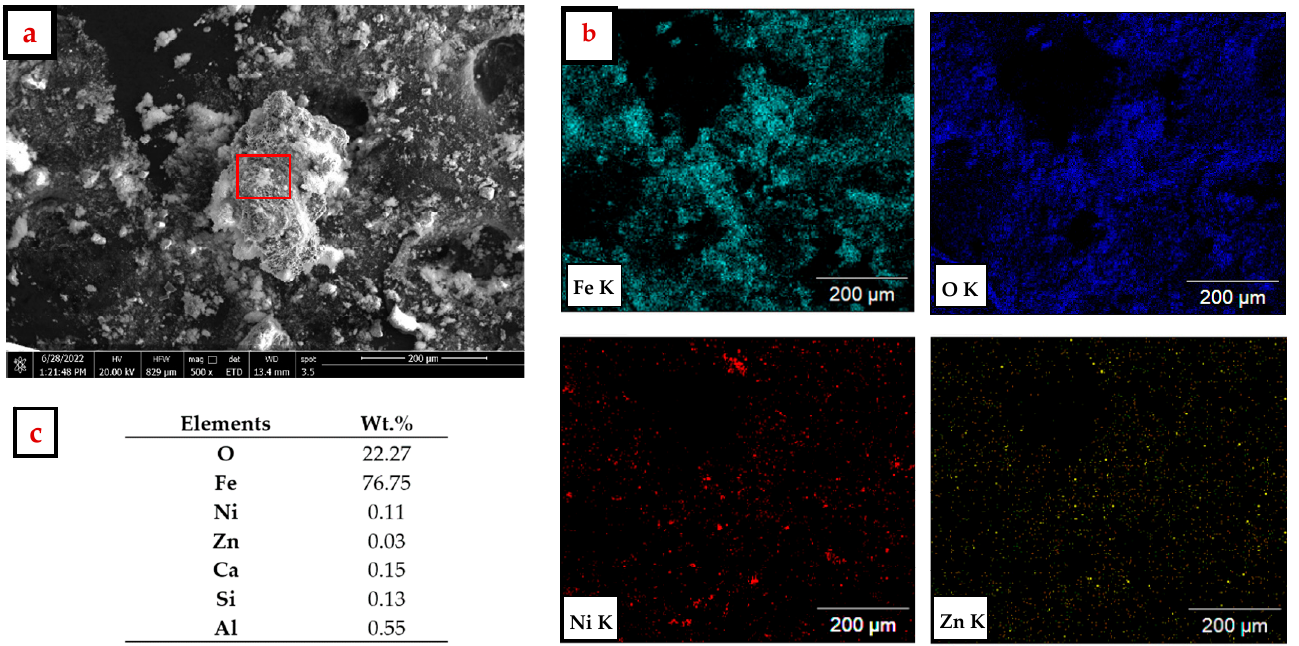
Figure 9. The backscattered electron image of the iron precipitate ( a ); distribution mapping of the different elements ( b ) and EDX element analysis of the red rectangle area ( c ). Table 4. Overall composition of the purified leachate before and after Fe and Mg precipitation (g/L).